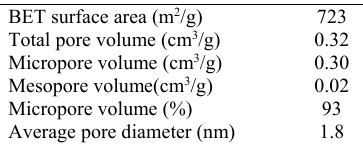
Table 1 Textural properties of the sample. Table 1. Textural properties of the